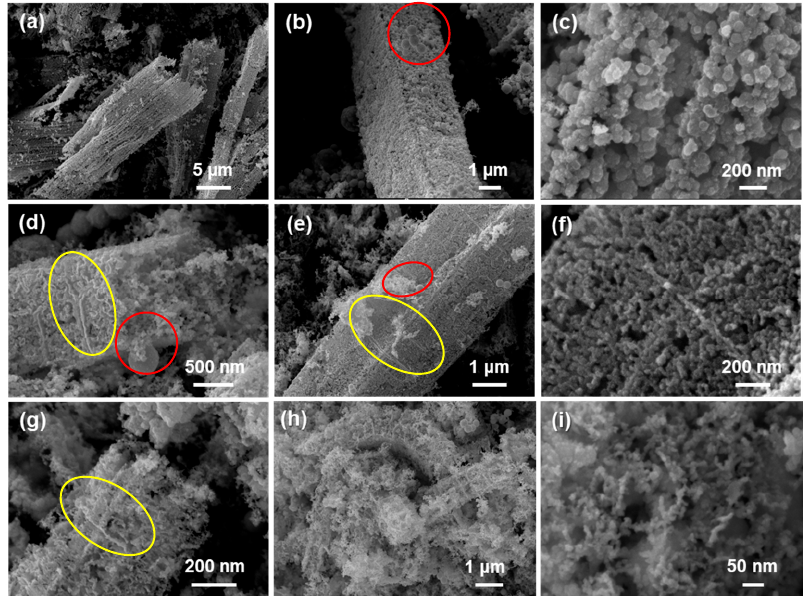
Figure 4. Scanning electron microscope images of platinum-copper macrobeam structures from 0.1